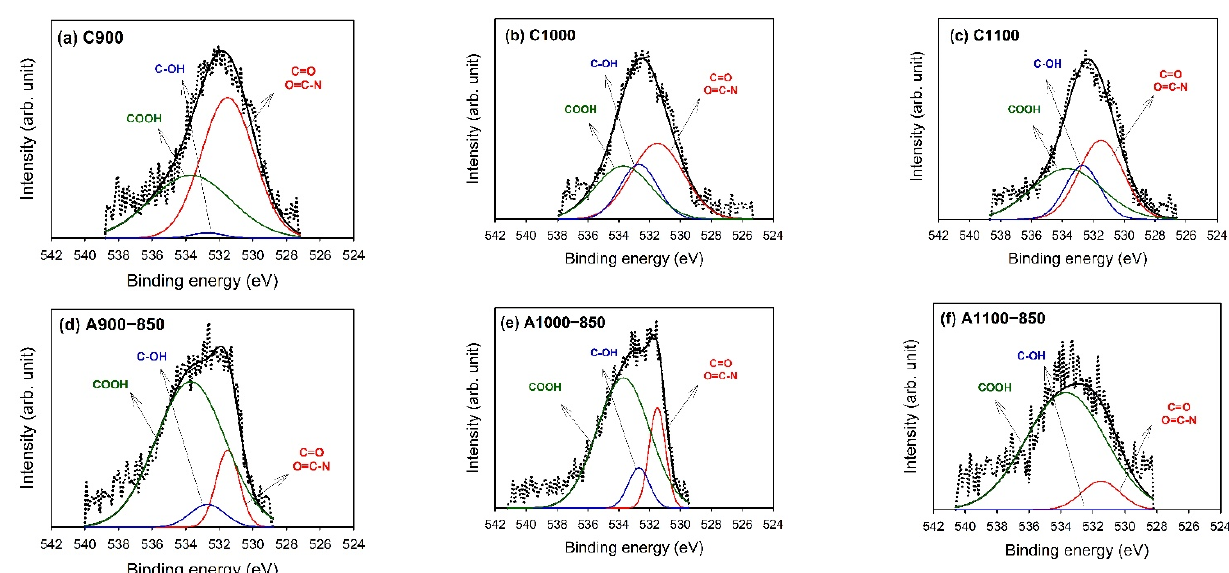
9 of 17 Figure 4. X-ray photoelectron spectroscopy (XPS) N 1 s spectra: ( a ) C900; ( b ) C1000; ( c ) C1100; ( d ) A900 − 850; ( e ) A1000 − 850; and ( f ) A1100 − 850. The values are given in an atomic ratio (%) of total intensity. Additional information on the nature of surface oxygen-containing functional groups might be provided from the deconvolution of the XPS O 1 s spectra (Figure 5). Compared with the XPS N 1 s peaks, the effect of treatments on the XPS O 1 s spectra represented different patterns. The carbonization temperature only had a subtle effect on the shape of the spectra; however, the CO 2 activation generated many more oxygen-containing func- tional groups at higher binding energies. Table 4 displays the atomic percentages of oxy-